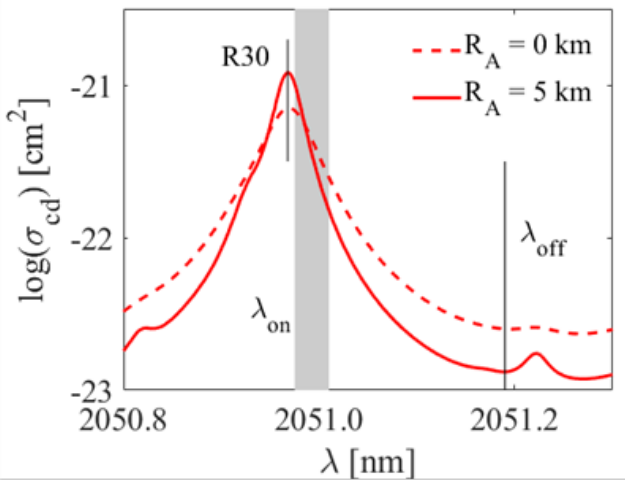
Figure 2. Transmitted on- and off-line wavelength settings for the 2- µ m IPDA lidar, in double pulse operational mode, with respect to CO 2 absorption spectra around R30 line. The spectra are calculated for sea-level and 5 km altitudes using HITRAN 2016 [18,24]. Gray area and black line mark the tunable on-line range and the fixed off-line wavelength positions.